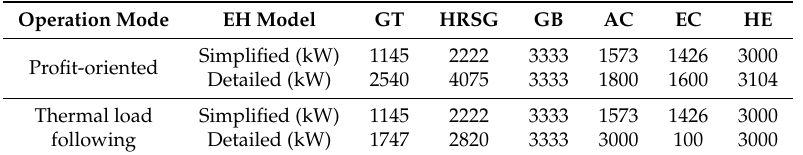
Table 6. Optimal capacities of generation units for the two cases. EC, electric